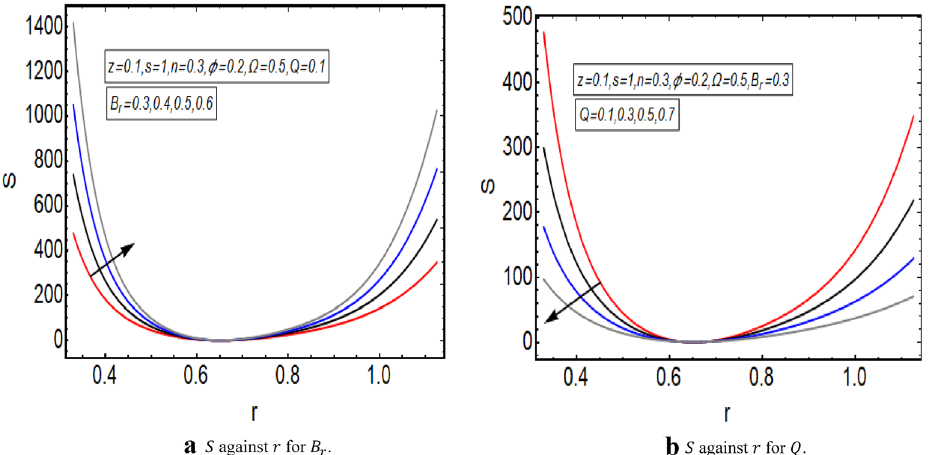
Figure 6. ( a ) S against r for B r . ( b ) S against r for Q